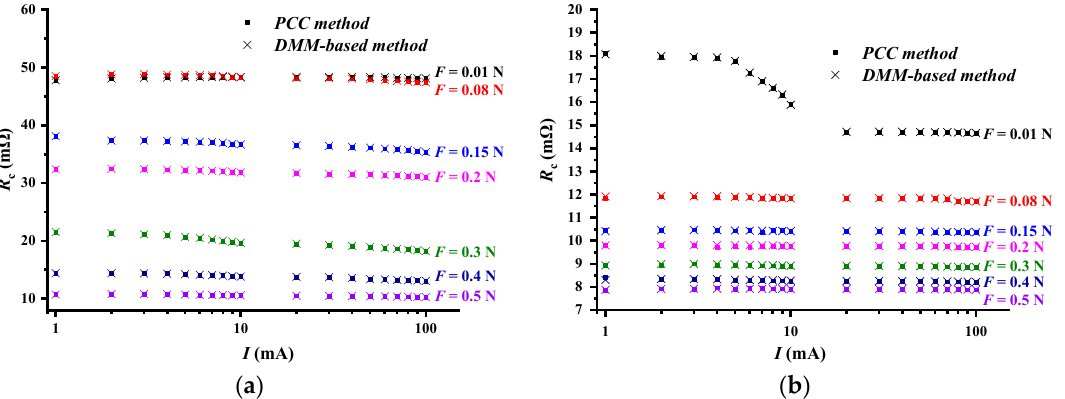
Figure 10. The measured results with varied test current I and contact force F . ( a ) Gold-plated rivet. ( b ) AgCdO rivet.